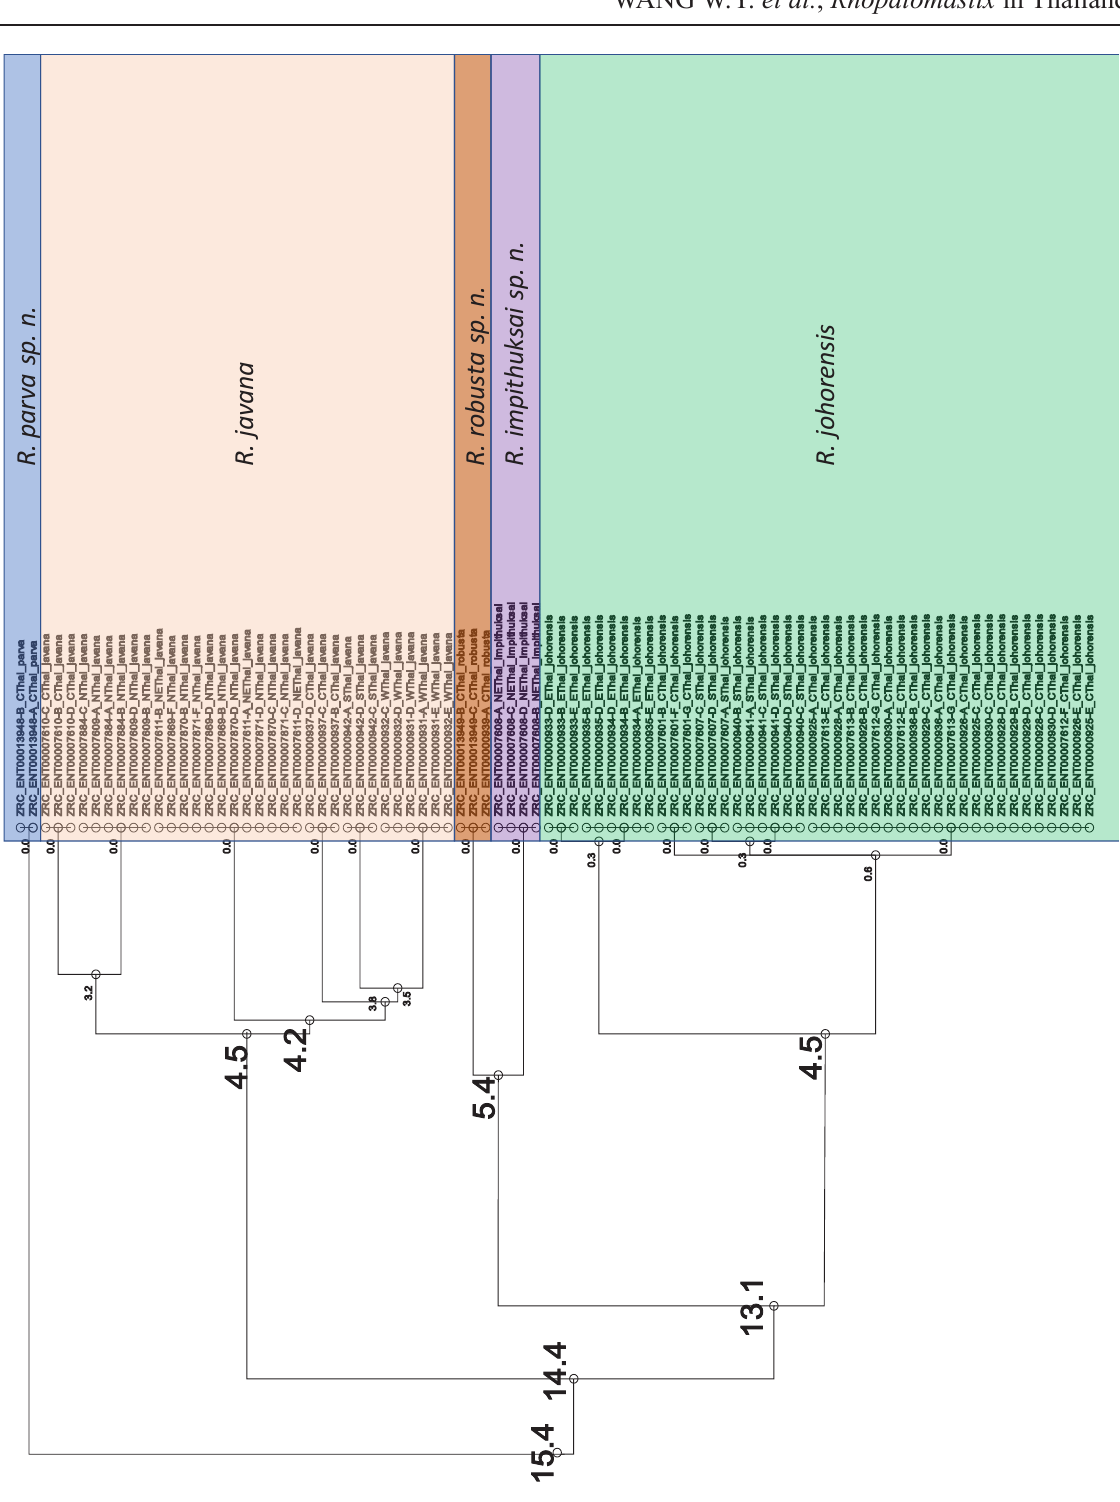
Fig. 1. Cluster dendrogram of COI (313 bp) barcodes of Rhopalomastix Forel, 1900 from Thailand. Objective clustering of barcodes was performed based on uncorrected p -distances using the ‘best close match’ criteria; numbers at nodes represent percentage divergences or pairwise distance thresholds at which clusters split or lump